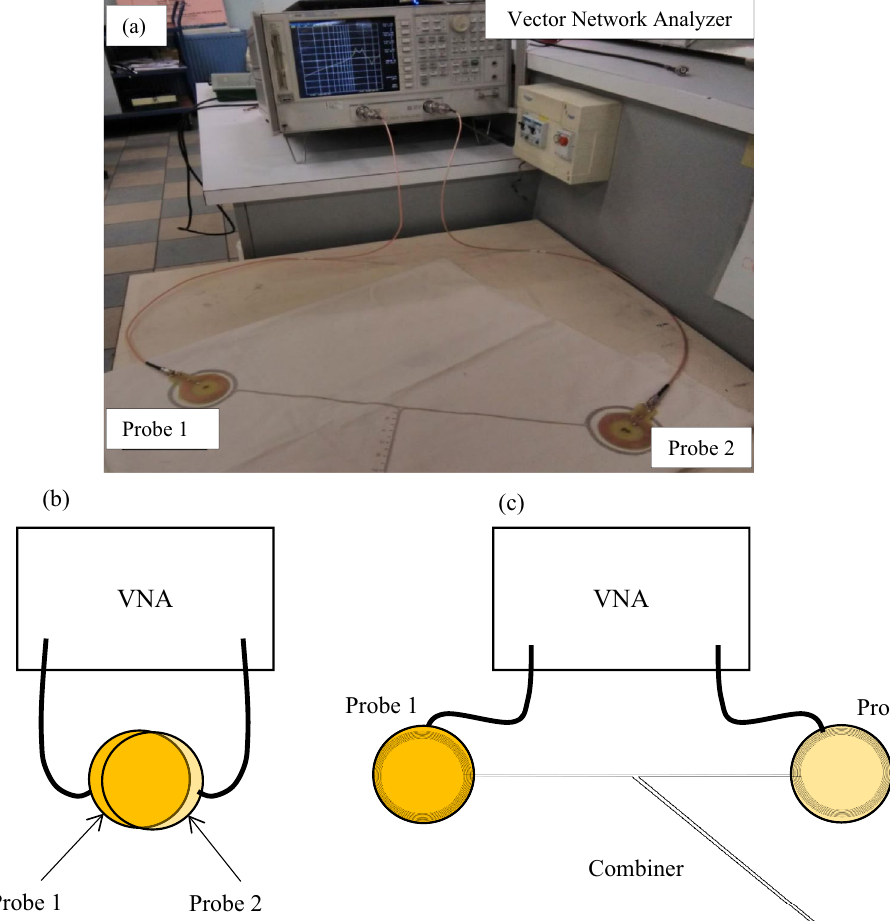
Figure 3. ( a ) Photo of the combiner S 21 parameter measurement experimental setup. ( b ) Diagram of the direct transmission between the two probes. ( c ) Diagram of the dual band combiner’s S 21 parameter measurement experimental setup. Figure 3( b ) and ( c ) were carried out using Microsoft PowerPoint 2016 16.0.4266.1001 (https:// www. micro soft. com/ en- ca/ micro soft- 365/ power